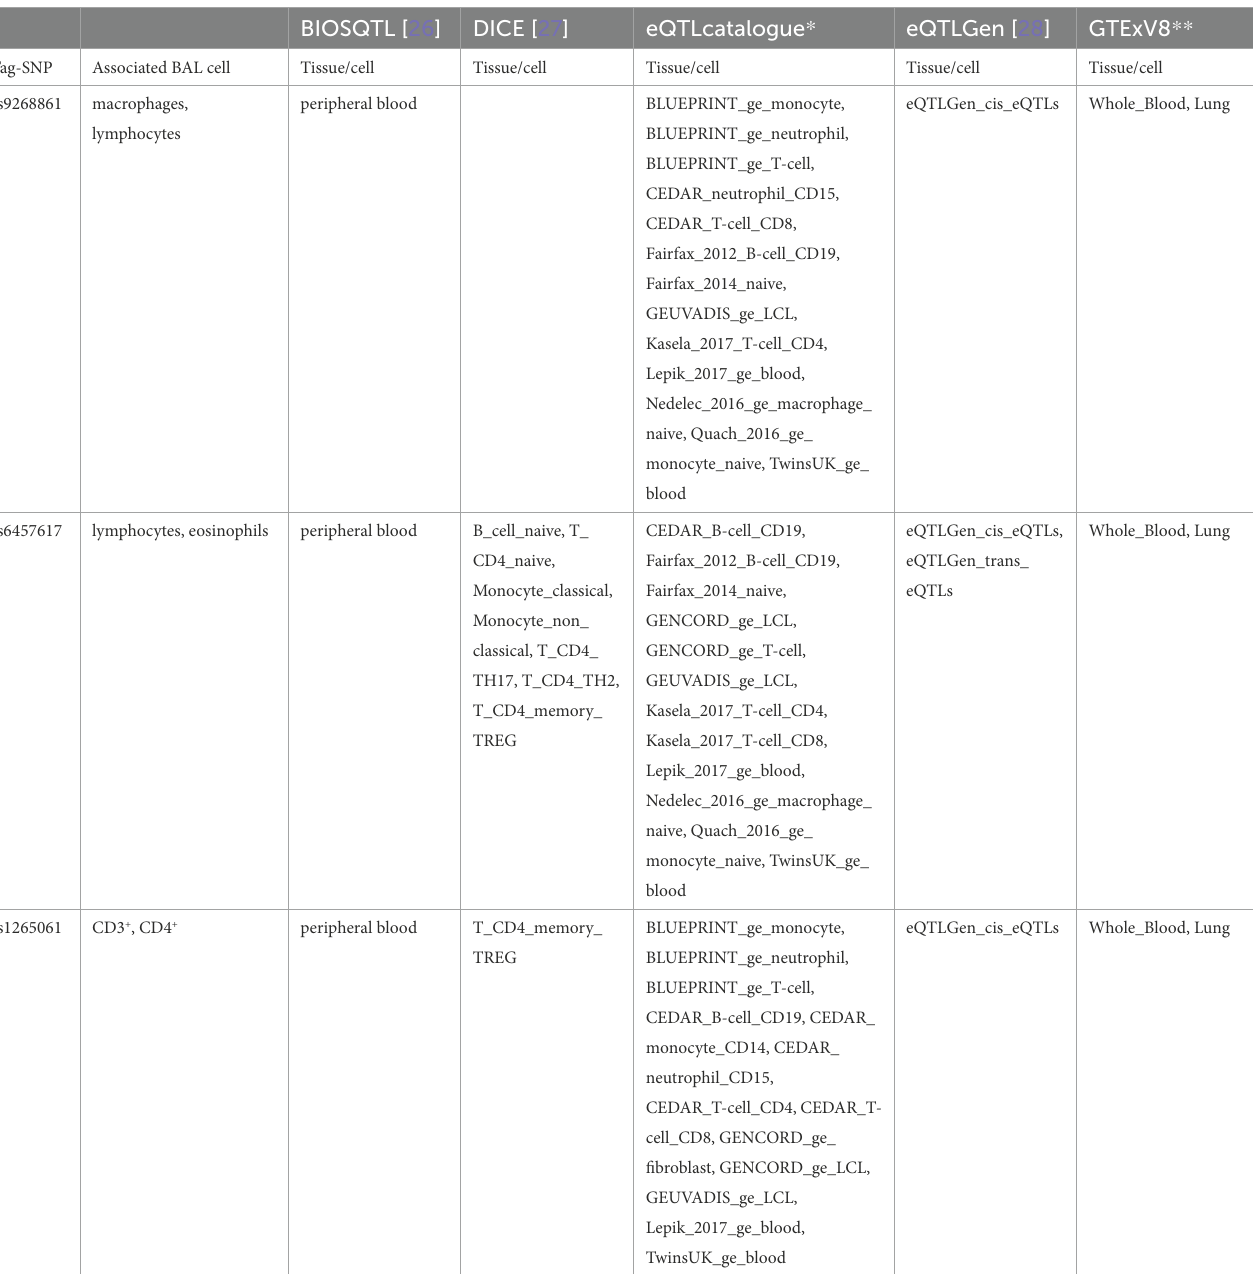
TABLE 5 Top LS SNPs associated with BAL cell types identified as eQTL